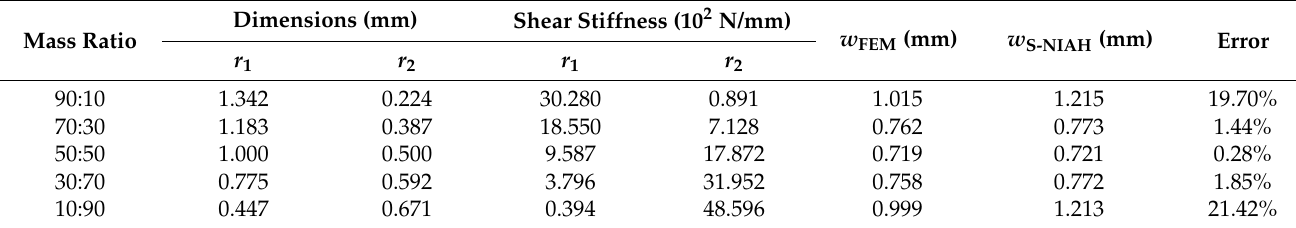
Table 7. Deflections and errors at mid-point under r 1 and r 2